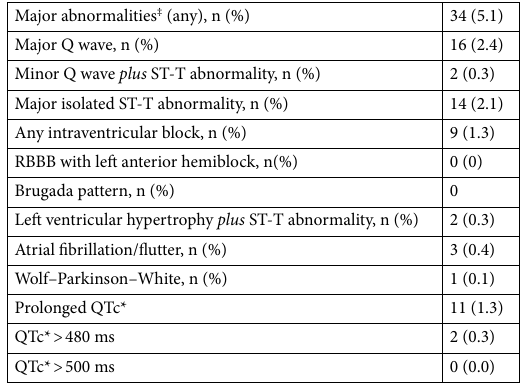
Major abnormalities ‡ (any), n